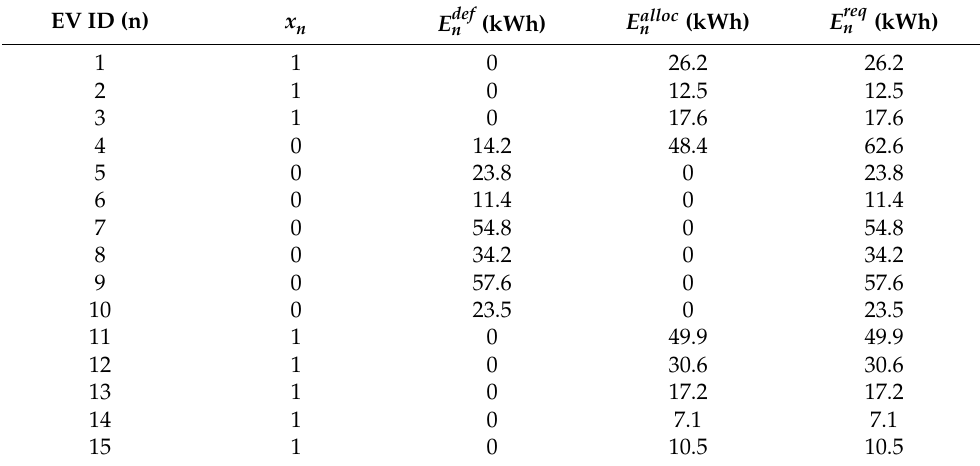
Table 4. Optimization results of the min–max